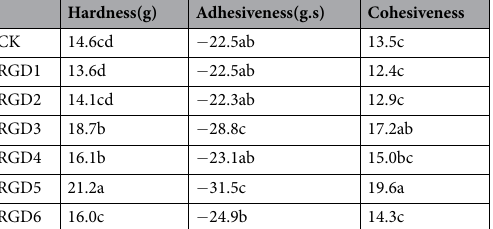
Table 2. Textural profile of the gels prepared from rice flour. Different letter indicates significant difference (P < 0.05).